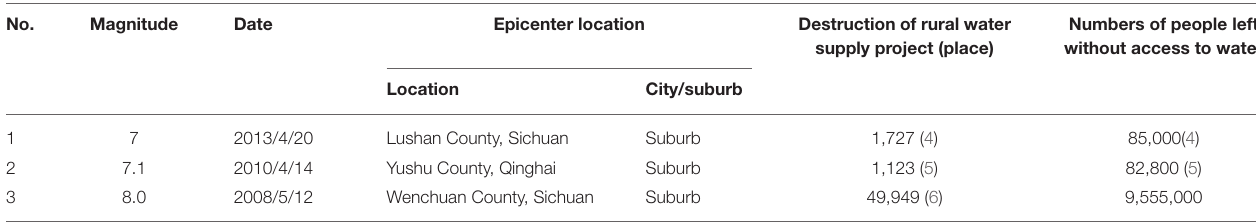
TABLE 1 | Damage to rural water supply systems (RWSSs) resulting from destructive earthquakes. No. Magnitude Date Epicenter location Destruction of rural water